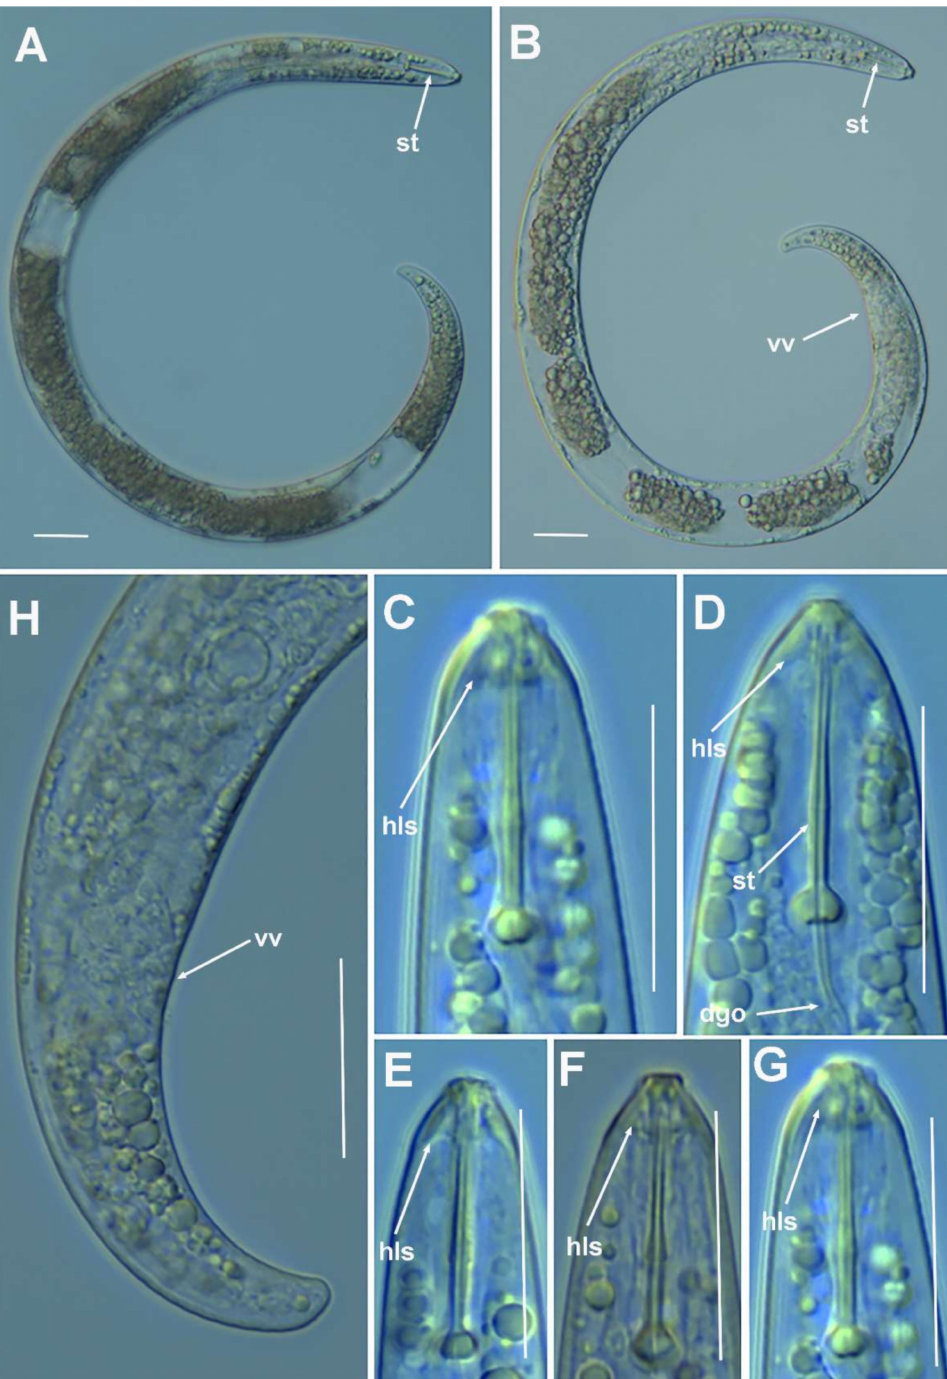
Figure 11. Light photomicrographs of Paratylenchus sheri (Raski, 1973) Siddiqi, 1986. ( A , B ) En- tire fourth-stage juvenile with stylet and vaginal vestigium arrowed; ( C – G ) fourth-stage juvenile lip region showing heavy lip sclerotization (arrowed); ( H ) fourth-stage juvenile with vaginal ves- tigium arrowed. Scale bars ( A – H = 20 µ m). (Abbreviations: dgo = pharyngeal dorsal gland orifice; hls = heavy lip sclerotization; st = stylet; vv = vaginal